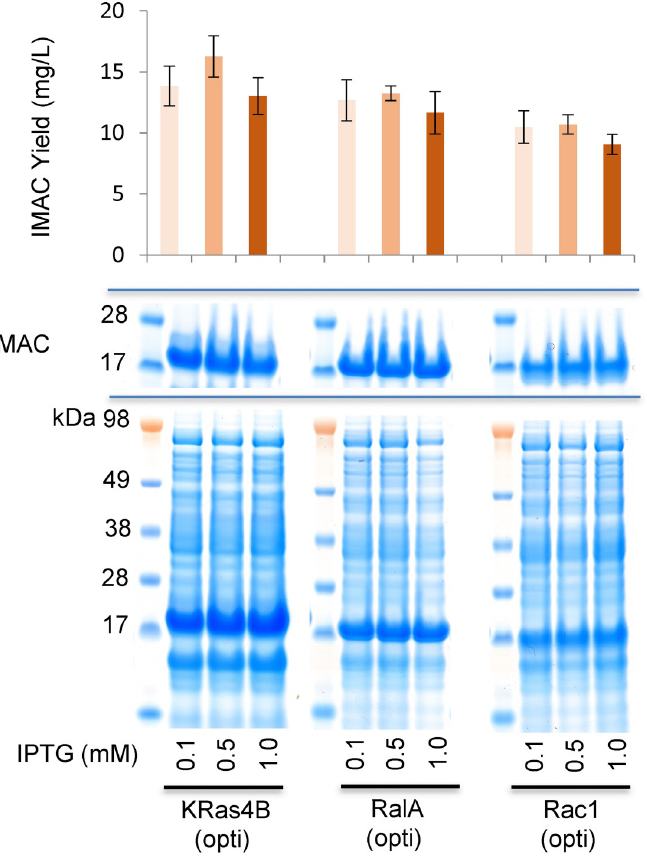
Fig 2. Tuning induction for soluble expression. SDS-PAGE and soluble fraction IMAC yield of codon optimized GTPase expression clones on titration of IPTG at induction. For each example, IPTG was applied at 0.1, 0.5mM or 1mM